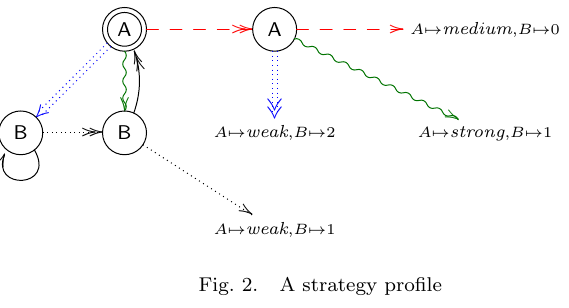
Fig. 2. A strategy